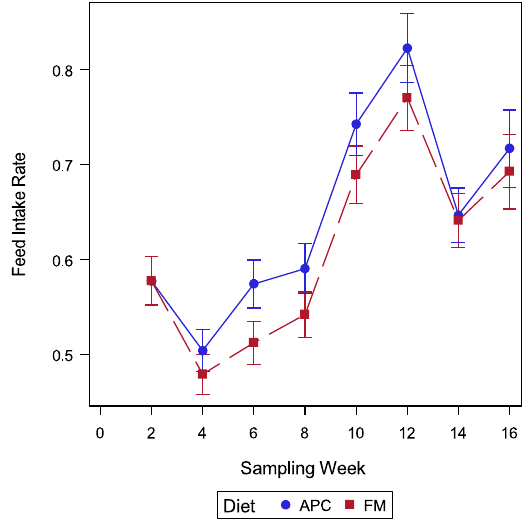
Figure 1. Feed intake rate for yellow perch averaged over the 16- and 14-week trials in 2017 and 2018, respectively. Values are means for each treatment (n = 8 for weeks 2–14 and n = 4 for week 16) ± standard error. No significant differences were measured between means at each week (alpha = 0.05). The treatments were isonitrogenous balanced diets with either 180 g/kg alfalfa protein concentrate (APC; solid blue line) or 150 g/kg fishmeal (FM; dashed red line). Feed intake rate = 100 × weight of feed consumed / (mean fish weight x population) / number of days.